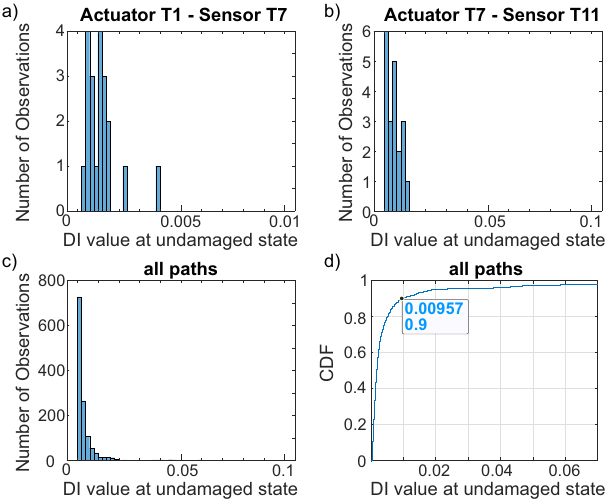
Figure 11. Histogram for damage index values for different paths, ( a ) T1–T7, ( b ) T7–T11, and ( c ) all paths, as well as those that do not cross the stringer. ( d ) Empirical CDF of damage index values given for all